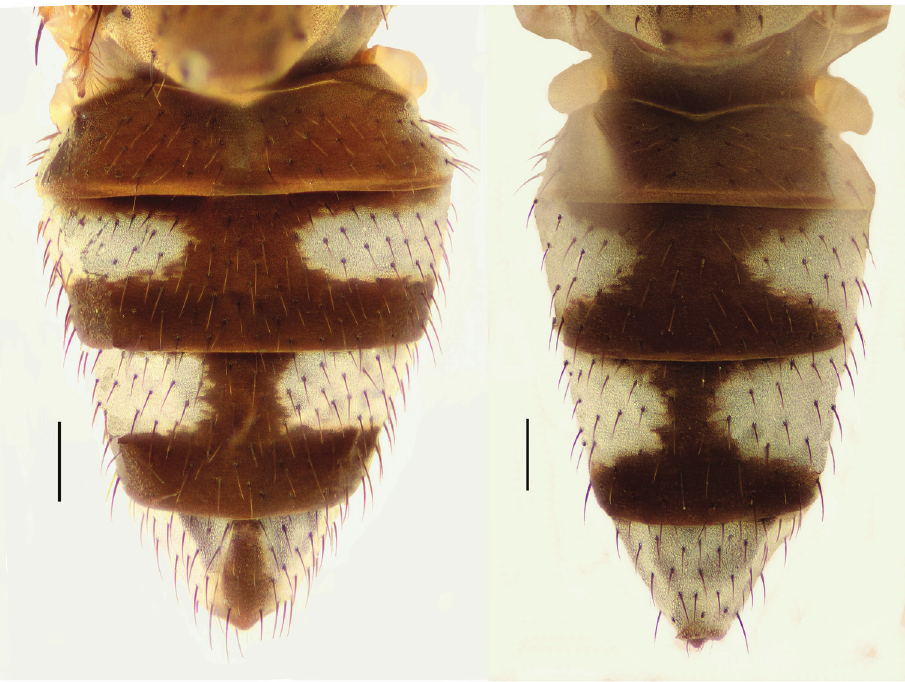
Figures 142–143. Abdomens of males, dorsal view. 142 Hydrochasma dolabrutum sp. n. (Jamaica. Clarendon: Barnswell Beach) 143 Hydrochasma urnulum sp. n. (Dominican Republic. LaVega: Jara- bacoa). Scale bar = 0.1